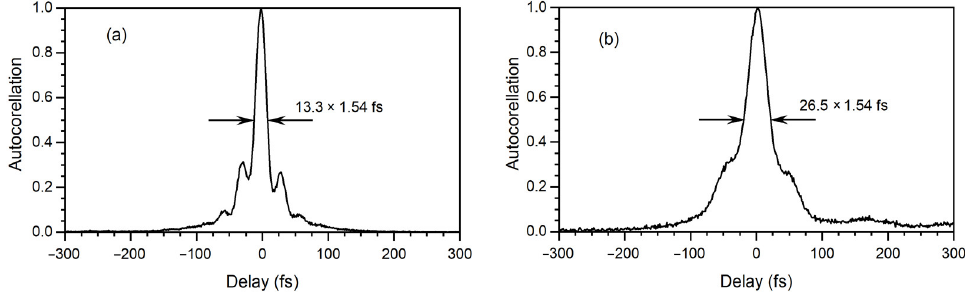
Figure 6. Autocorrelation functions of compressed pulses. Xenon pressure, input pulse energy, number of reflections from chirped mirrors were ( a ) 15 atm, 3.8 μJ, 10 and ( b ) 40 atm, 1.5 μJ, 20, of reflections from chirped mirrors were ( a ) 15 atm, 3.8 µ J, 10 and ( b ) 40 atm, 1.5 µ J, 20, respectively.